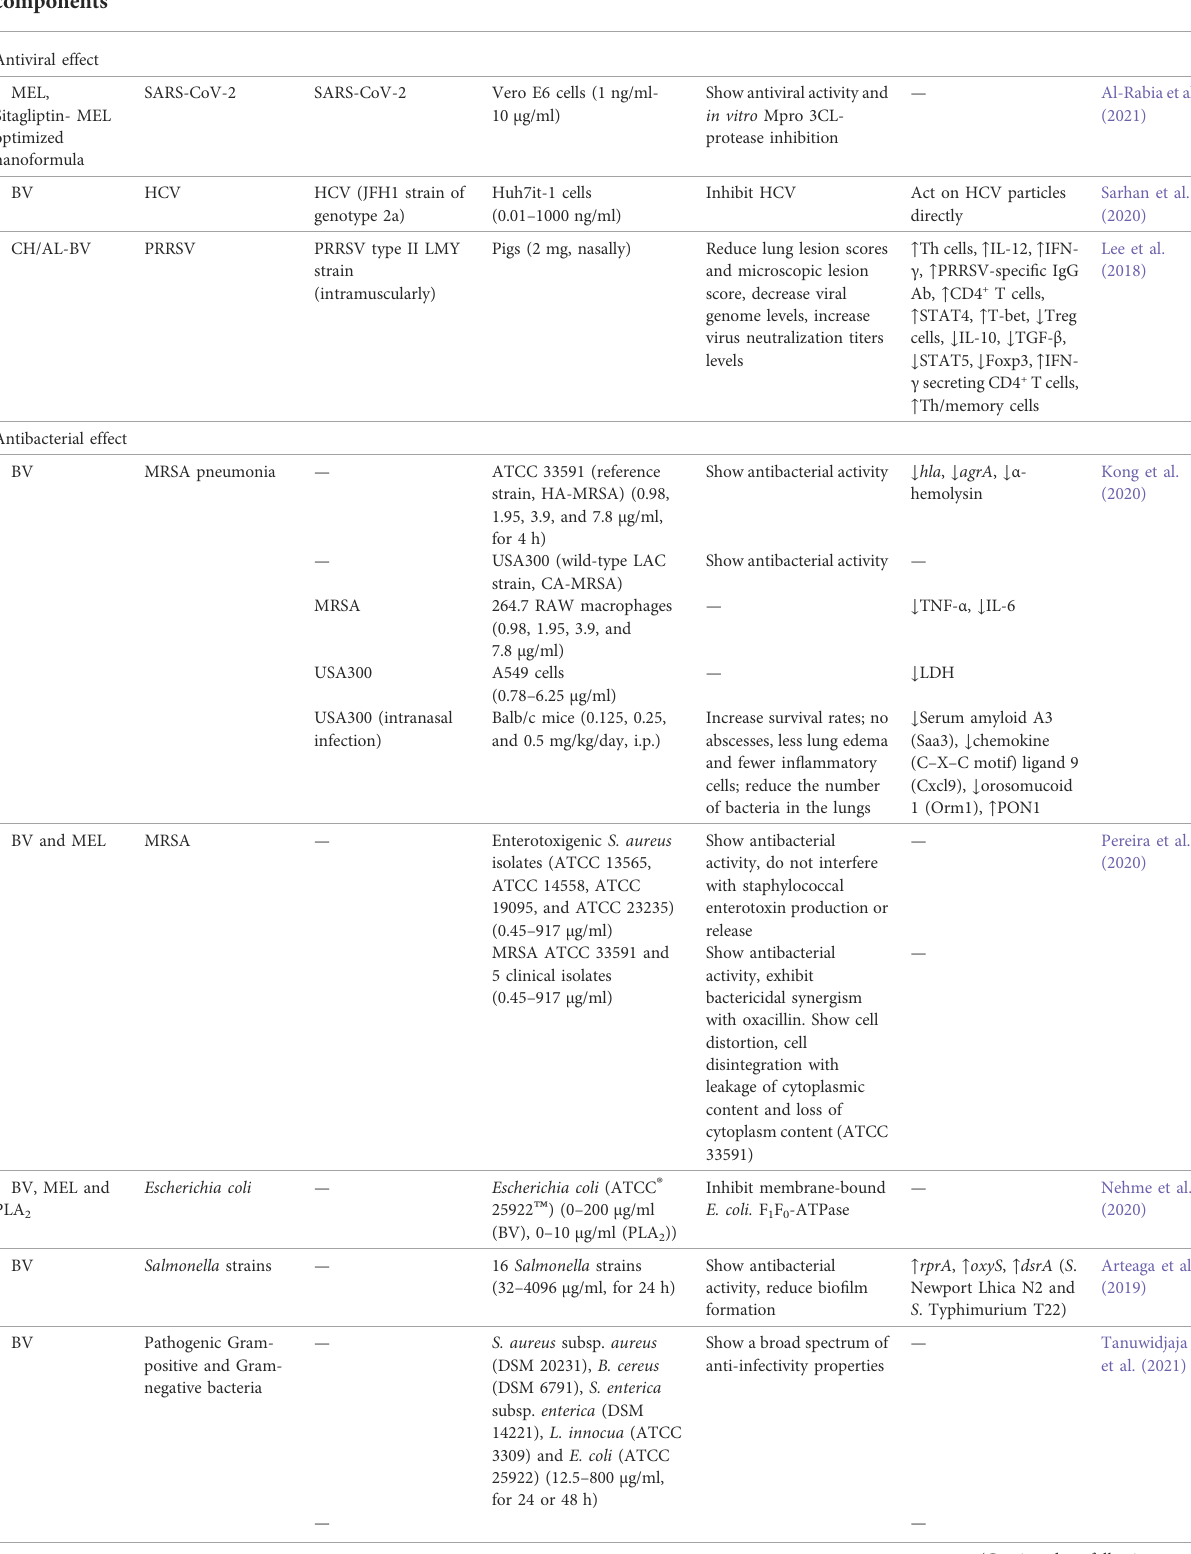
TABLE 5 Summary of the anti-infectivity effects and mechanisms of BV and its main